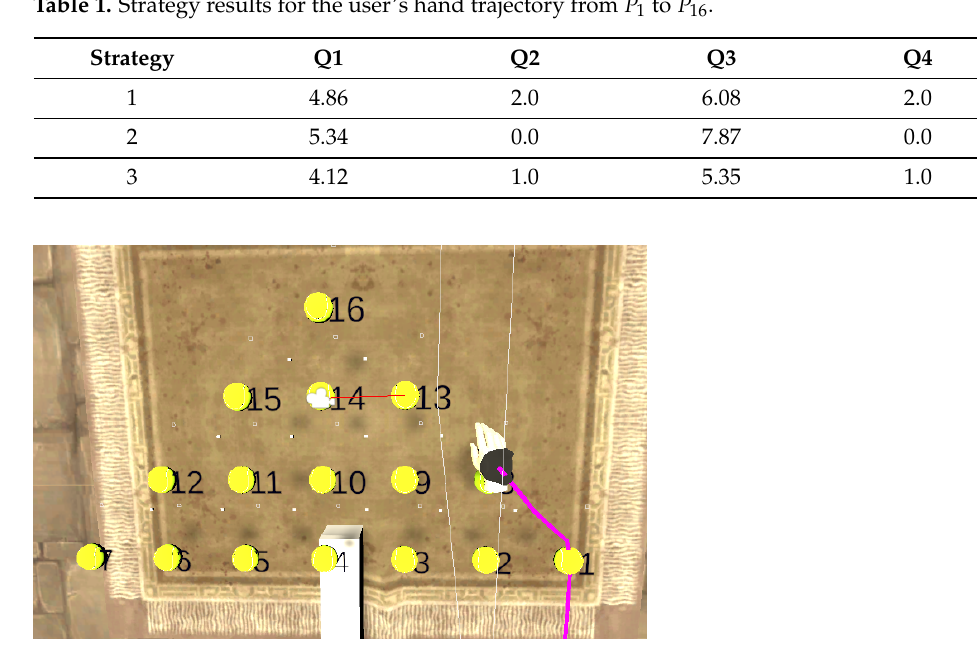
Figure 9. User’s hand trail and selection by eye gaze for motion from P 1 to P 16 . The hand trail is shown as a pink line. The ball selected by the eye-gaze direction is P 13 , indicated by a slim red line from the camera, represented as an icon.